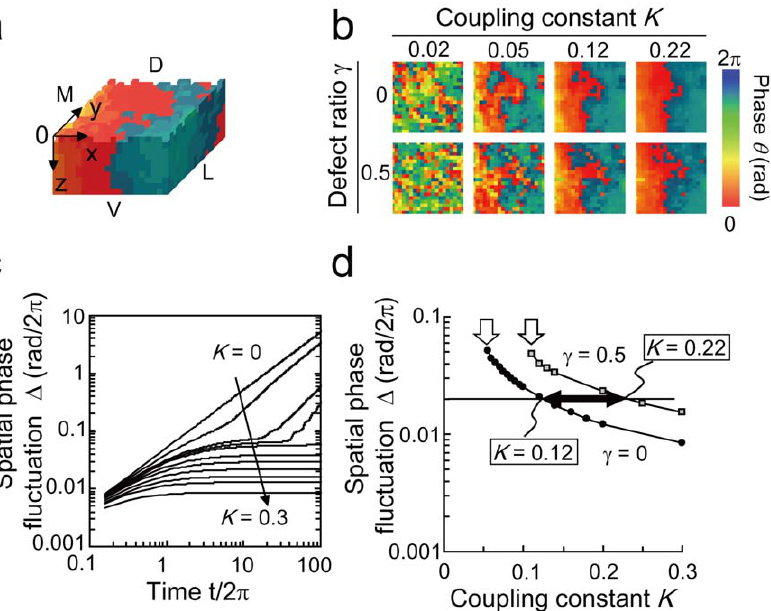
Figure 3. Estimation of the intercellular coupling strength by the model simulations. (a) Phase image of the SCN slice with a multi-layer structure. The pacemaker is located on the x=0 plane, where oscillation frequency of the cells is 4% faster than that of the neurons in the other regions. The directions of ventral (V)/dorsal (D) and medial (M)/lateral (L) have been illustrated. The color map is the same as in Fig. 2a. (b) Phase patterns on the surface of SCN (z=0). (c) Time evolution of D for various values of K (from top to bottom, K =0, 0.02, 0.04, 0.045, 0.05, 0.07, 0.09, 0.12, 0.16, 0.2, 0.3). (d) D as a function of K . White arrows indicate the critical value of K c . Black arrow indicates the coupling strength region estimated for experimental SCN. The parameters were set as N L =10 and s v